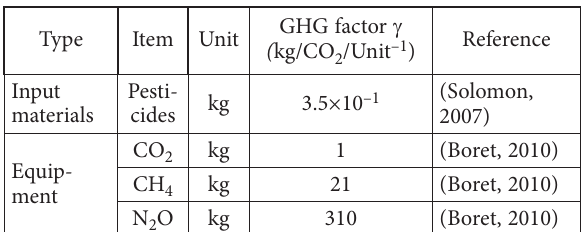
Table 5. GHG factors of the site maintenance input materials and equipment